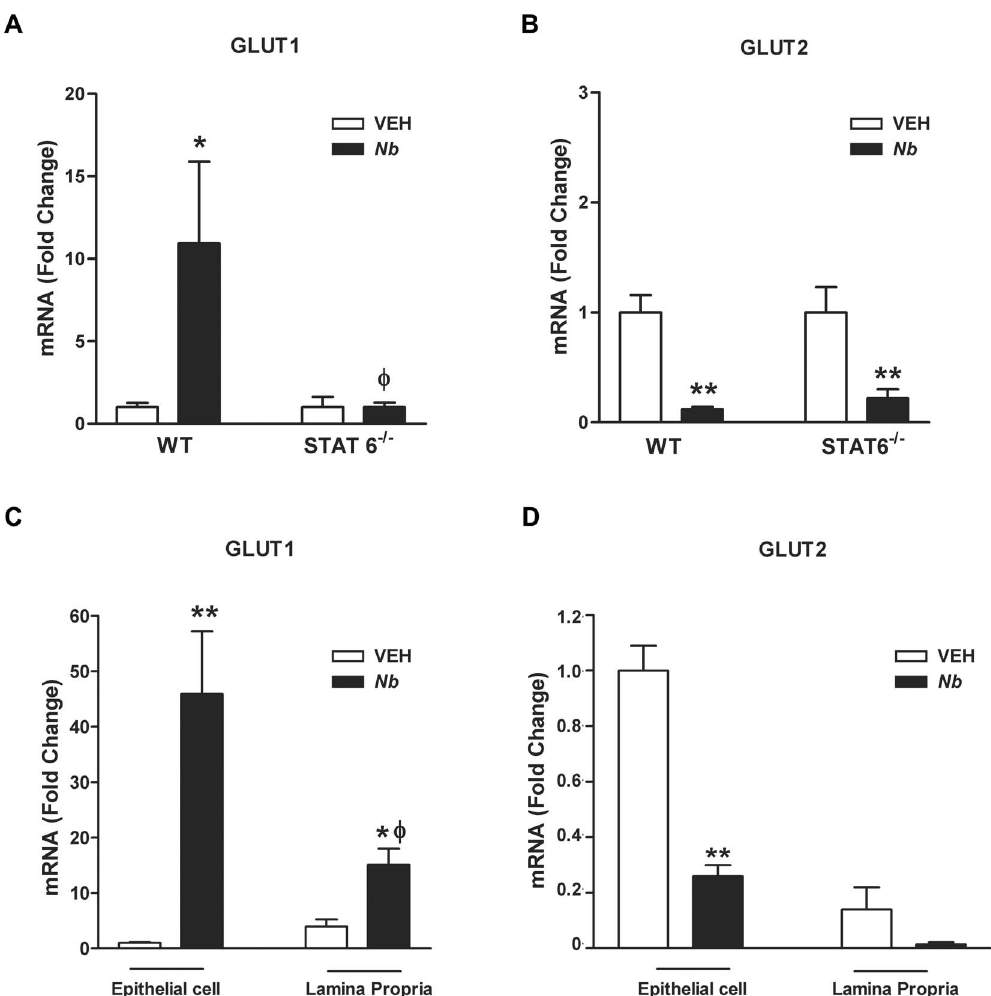
Figure 4. Immune regulation of glucose transporter expression and localization of GLUT1 and GLUT2 transporters. WT or STAT6 2 / 2 mice were treated with vehicle (VEH) or were infected with N. brasiliensis (Nb). At day nine post infection, full thickness sections of small intestine were prepared for real-time qPCR to determine the mRNA expression of (A) GLUT1 or (B) GLUT2. WT mice were treated with vehicle (VEH) or were infected with N. brasiliensis (Nb). At day nine post inoculation, sections of small intestine were prepared for laser capture micro-dissection (LCM) to determine (C) GLUT1 or (D) GLUT2 mRNA expression in epithelial cells or in the lamina propria. Values shown are means 6 SE; **p , 0.05 vs VEH Control; w p , 0.05 vs WT N. brasiliensis